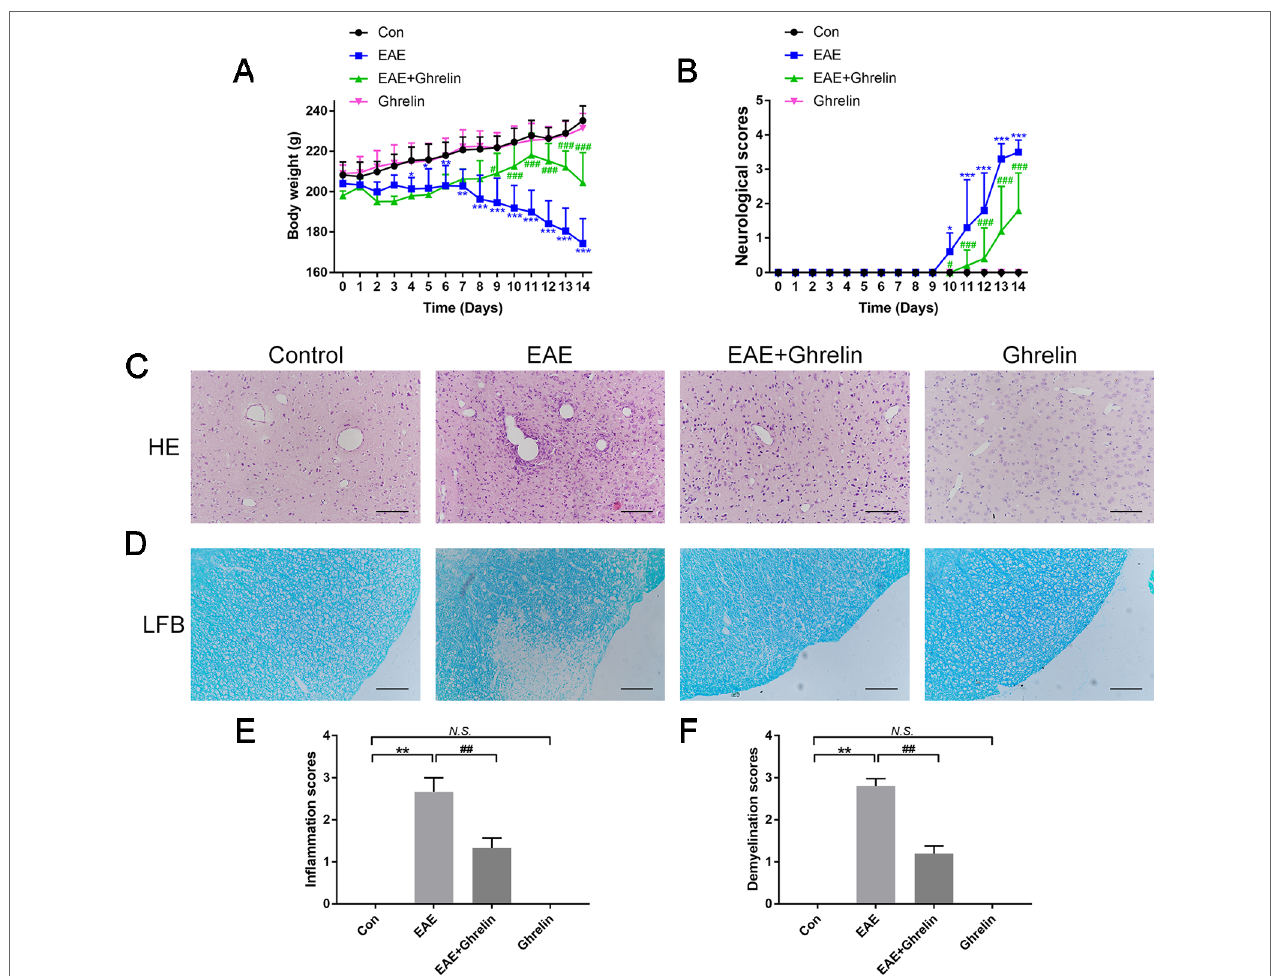
FIGURE 1 | Treatment of ghrelin ameliorated symptoms and suppressed inflammatory infiltration and demyelination in CNS tissues of EAE rats. (A) Body weight changes of rats during the experimental period ( n = 10). (B) Variations of neurological scores during the experimental period ( n = 10). Statistical analysis of different groups was performed with two-way ANOVA followed by Bonferroni’s multiple group comparison. (c) H&E staining showed that ghrelin attenuated inflammatory infiltration in brain tissues of EAE rats. (D) LFB staining showed that ghrelin attenuated demyelination in spinal cord tissues of EAE rats. Inflammation scores ( n = 5) (E) and demyelination scores ( n = 5) (F) were markedly decreased in the ghrelin-treated group. Scale bars: 50 μm. Data were shown as mean ± SD. * P 0.05, ** P 0.01,*** P 0.001 versus the control group, # P 0.05, ## P 0.01, ### P 0.001 versus the EAE group. NS , not significant. Con,